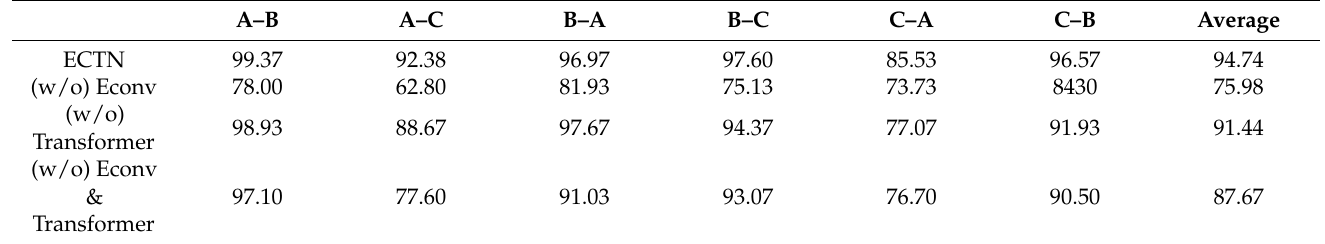
Table 6. Ablation experiments with 3000 training samples on CWRU.